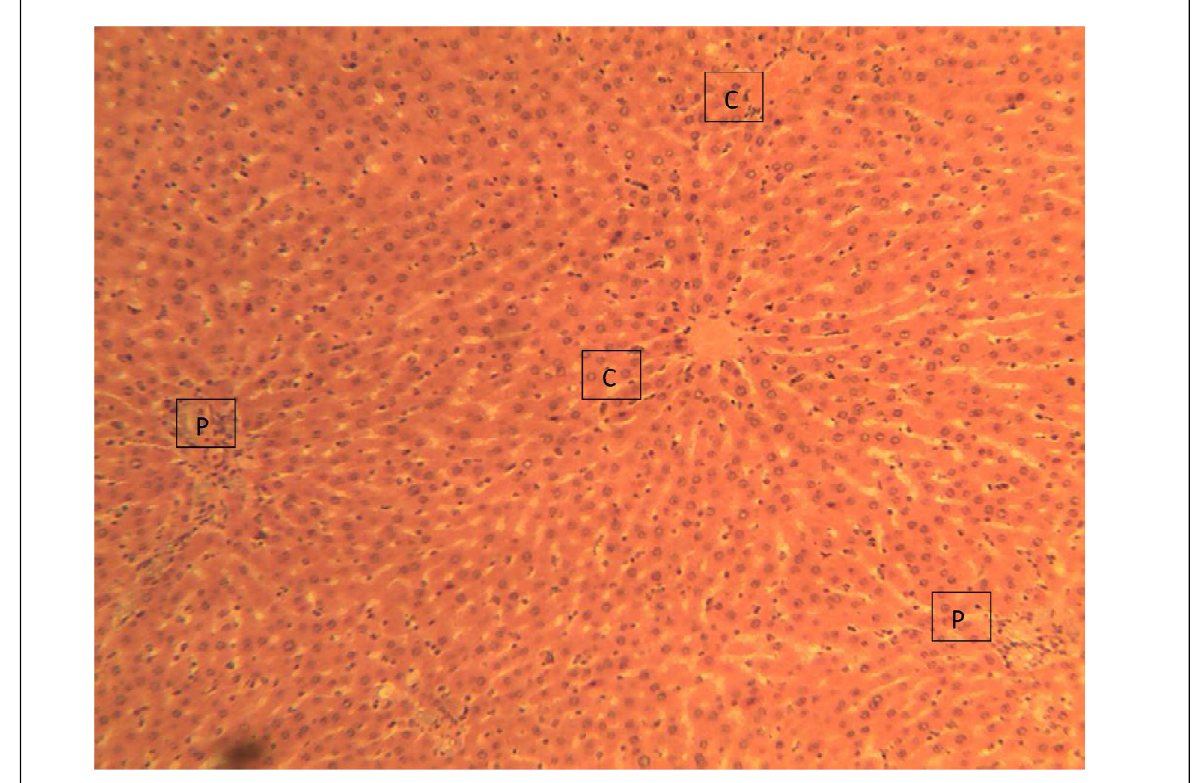
Plate 11: Control group of the female albino rats liver exposed to no extract